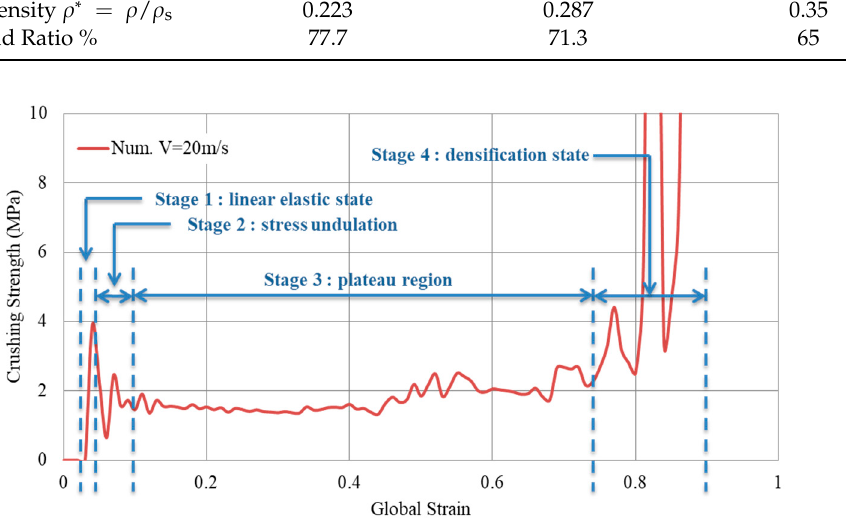
Figure 23. Stress-strain curve of Aux. 1 under 20 m/s impact velocity, showing the four stages of crushing re-entrant auxetics.